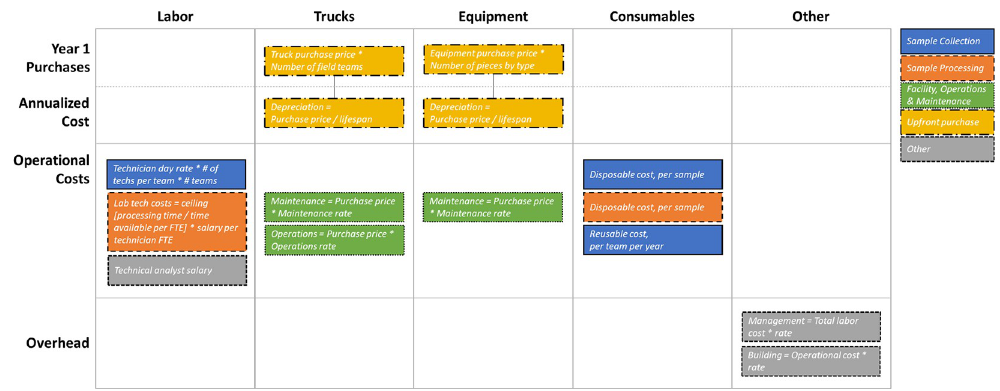
Fig 1. Cost model components, categorized by type and color-coded by function. Detailed descriptions and formulas can be found in Table A in S3 Text. Operational costs include labor, truck operations and maintenance, equipment maintenance, and